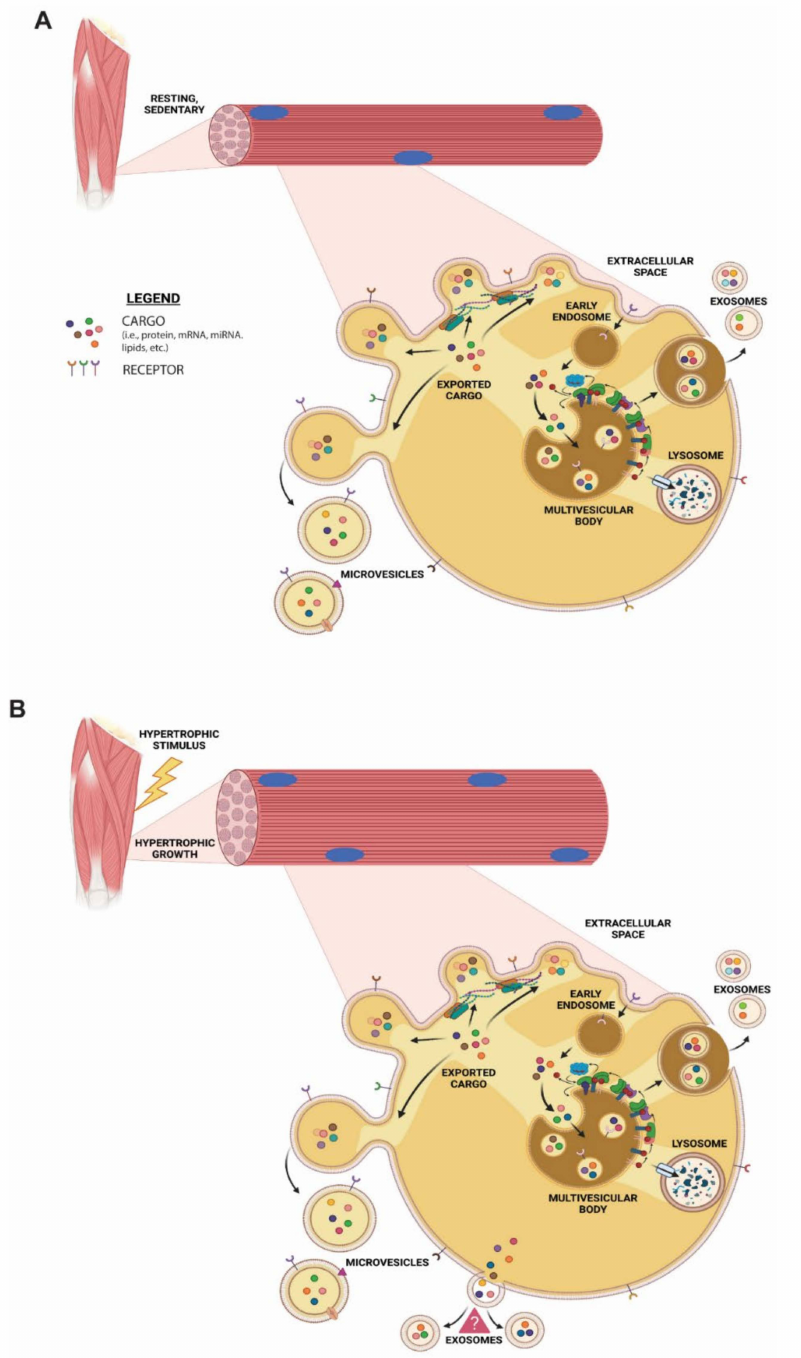
Figure 7. Proposed model of EV biogenesis in C2C12 myotube cells in resting conditions ( A ) and during muscle growth ( B ). In resting conditions, microvesicles and exosomes are formed through a canonical EV biogenesis mechanism, whereas during muscle growth an additional non-canonical exosome biogenesis mechanism might take place at the plasma